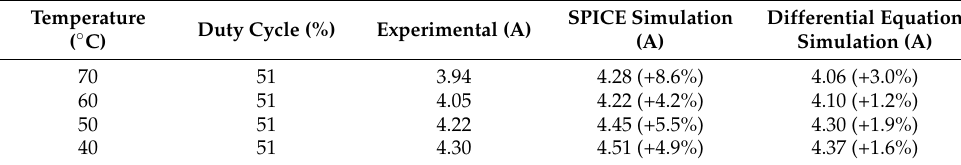
Table 3. RMS current (in A) comparison when the duty cycle is 51%.